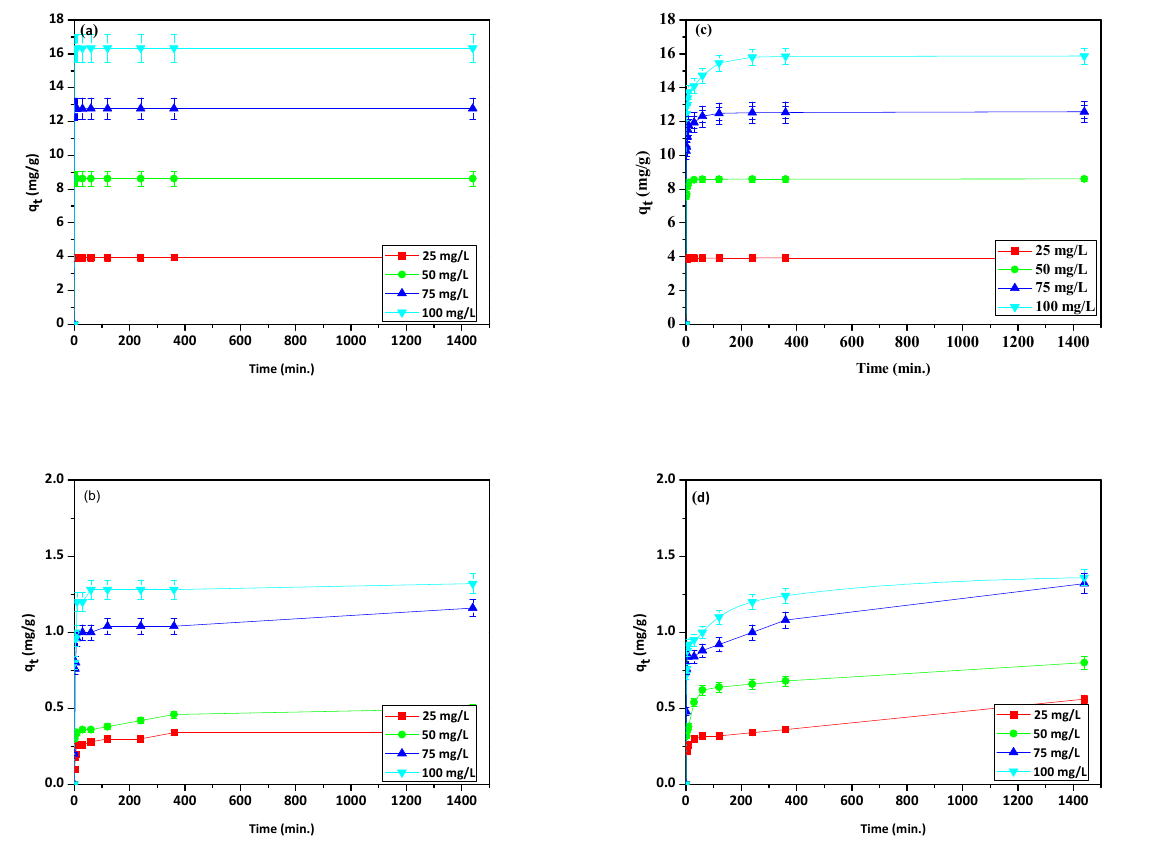
Figure 6. Effect of contact time and initial concentration on sorption capacity of ( a ) Cu(II), ( b ) phenol on NaP1, ( c ) Cu(II), and ( d ) phenol on NaP1CS ( C 0 = 25, 50, 75, 100 mg/L of Cu(II) and phenol, m = 0.1 g).